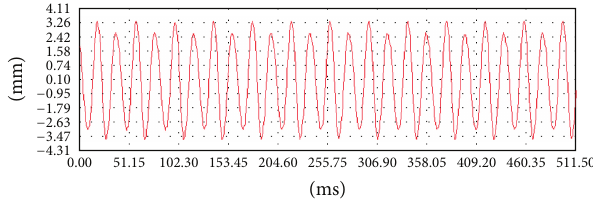
Figure 13: Wingtip’s dynamic response of a controlled SMA com- posite wing when the mean wind velocity 𝑉 = 6 m/s.